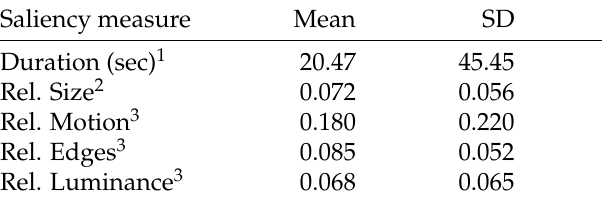
Descriptive statistics of advert saliency measures.